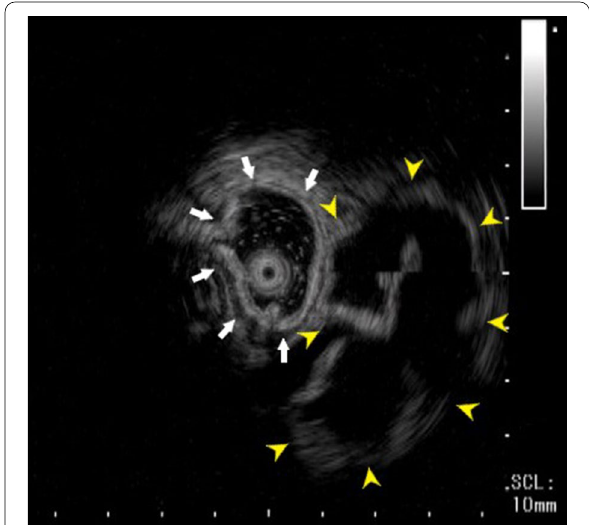
Fig. 3 EUS showed a cyst (yellow arrowheads) outside the intestinal tract (white arrows). The cyst had a uniform wall with septa, showed no obvious irregular nodules or solid components, and had no internal